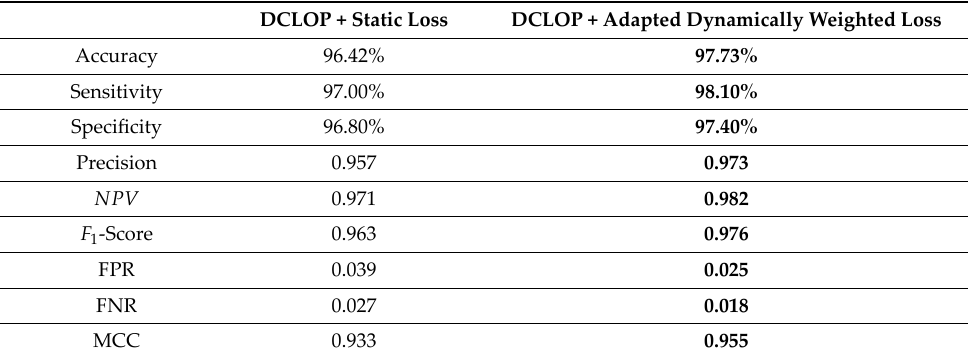
Table 2. Deep clustering performance evaluation results for